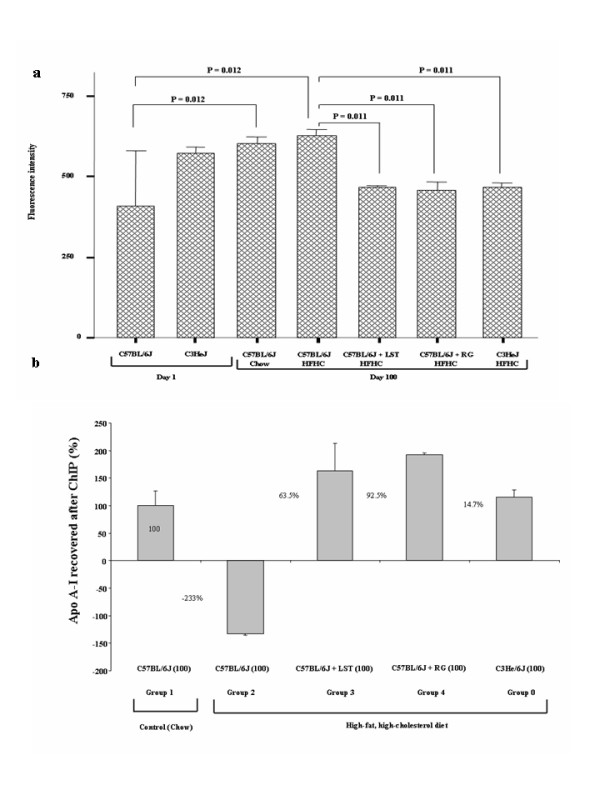
Treatments preserve HDL antioxidant properties and apolipoprotein A-I-(apo A-I)-PPARγ-mediated gene expression. (a). Fluorescence intensity (arbitrary units) was determined as described in Methods. There was no difference in the fluorescence signal levels measured of the HDL isolated from mice under control diet with respect to that obtained from mice that fed a HFHC diet after 1 day elapsed; thus the average fluorescence value obtained of the HDL from both groups was taken as "Day 1" reference value. Data are mean ± SD from thee separate experiments. (b). ChIP with a PPARγ antibody of study groups were used to amplify an apo A-I promoter fragment. ChIP figures percentages indicate increments or decrements regarding C57BL/6J mice fed HFHC diet. Data of C57BL/6J mice fed chow diet was established as 100%.